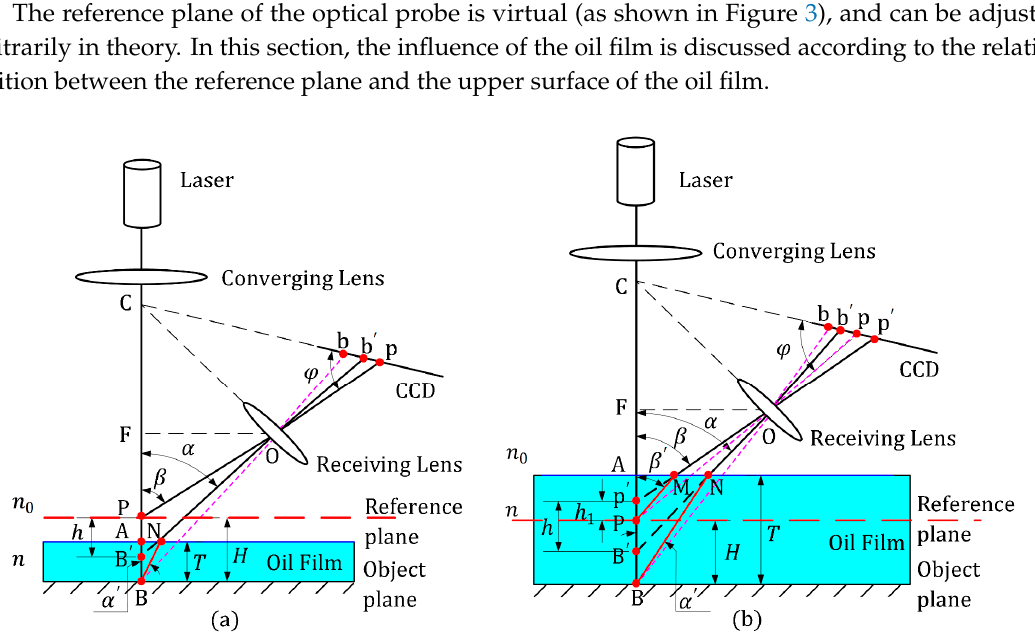
Figure 2. Local magnification of the change for incident light intensity.